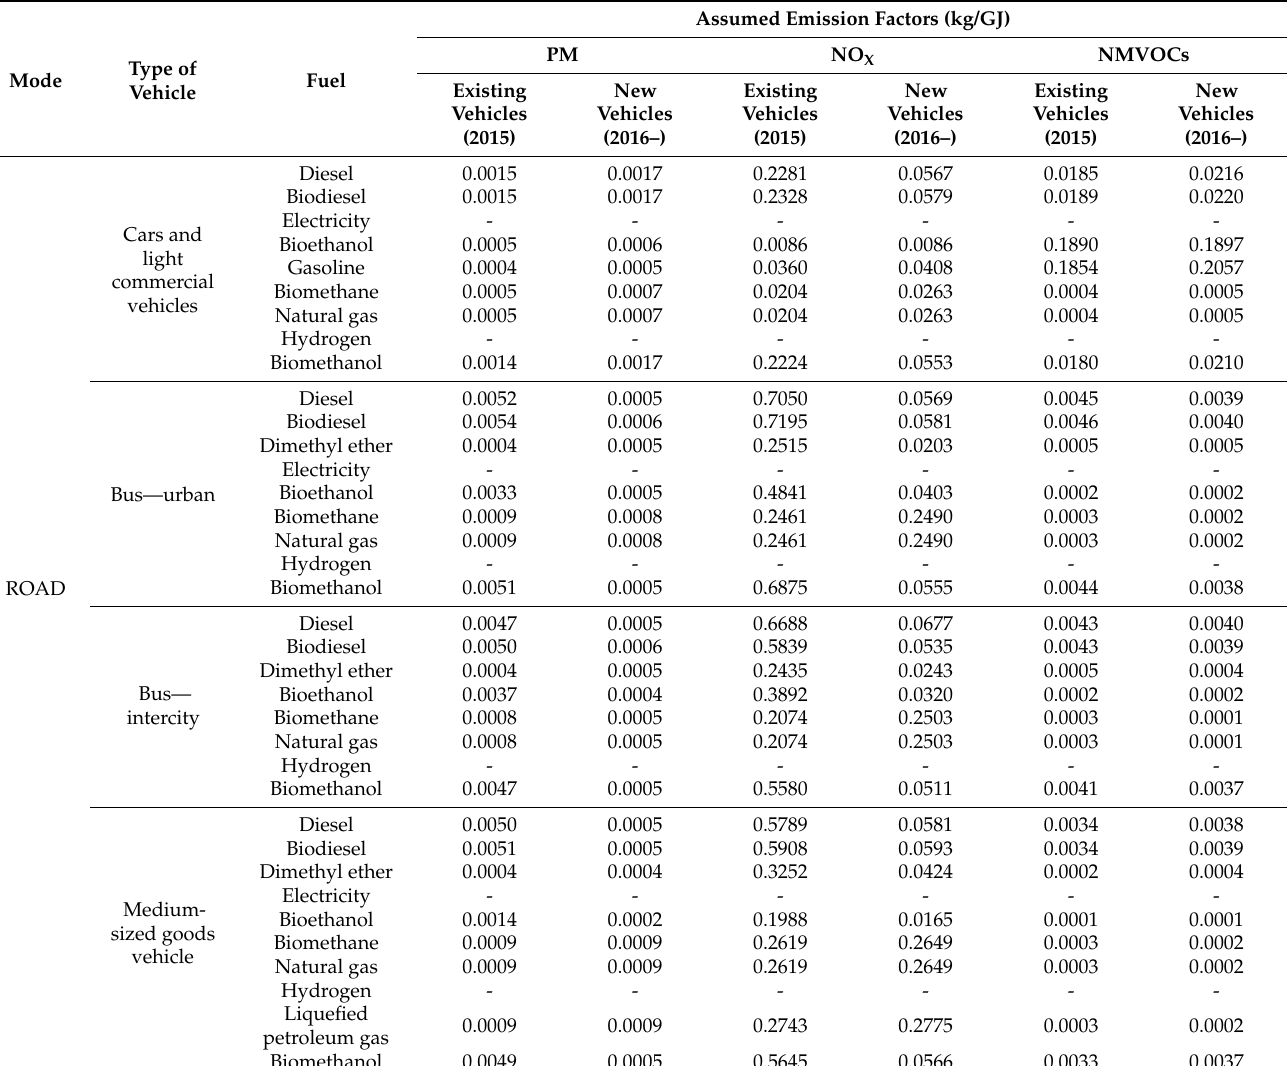
Table A2. Assumed emission factors for particulate matter (PM), nitrogen oxides (NO X ) and non-methane volatile organic compounds (NMVOCs), in the reference year (2015) and for new vehicles (2016–), respectively